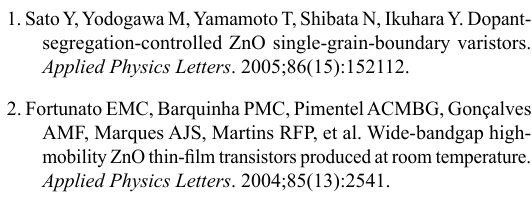
to the symmetric and asymmetric C=O bond stretching. The deformation bands of C=O can also be observed at 980 cm -1